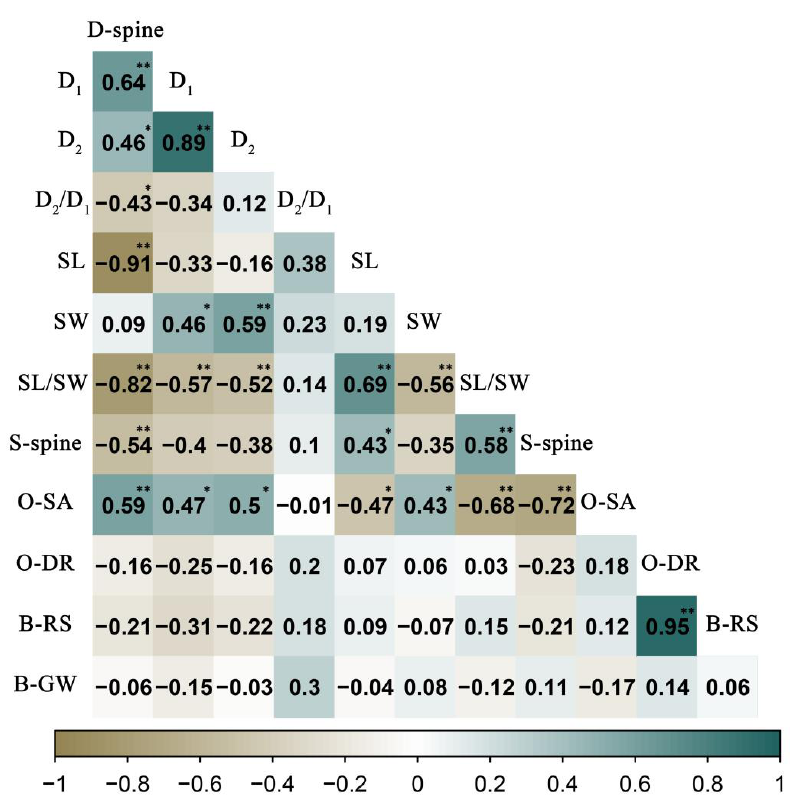
Figure 5. Heatmap of correlations between eight quantitative and four qualitative traits of pollen grains of Hibiscus syriacus . The degree of a correlation is indicated by its shaded coloring, with positive or negative numbers in the small square boxes indicating positive or negative correlations between row and column traits, respectively. * p < 0.05, ** p <